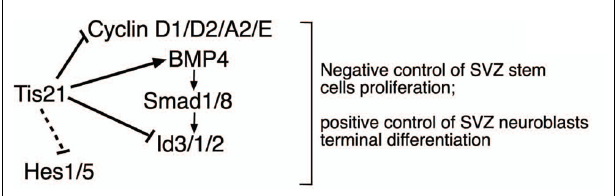
FIGURE 10 |Working model for the control of the adult SVZ neurogenesis by Tis21 . This model depicts in the SVZ the effectors by which Tis21 inhibits proliferation of stem cells and is required for the differentiation of neuroblasts in vivo and in vitro .The silencing of Id3 or the treatment with BMP4 in Tis2 1-null neurospheres rescues their defect of differentiation, indicating that by regulating the expression of these molecules Tis21 acts as upstream controller of the opposite actions they exert in the SVZ, i.e., anti-differentiative for Id3 and prodifferentiative for BMP4 .The dotted lines indicate only correlative evidence.The negative regulation of cyclin D1 by Tis21 has been demonstrated in several neural and non-neural systems (Farioli-Vecchioli etal., 2007;Tirone etal., 2013), while the direct regulation of the Id3 promoter by Tis21 has been previously shown in neural cells (Farioli-Vecchioli etal.,